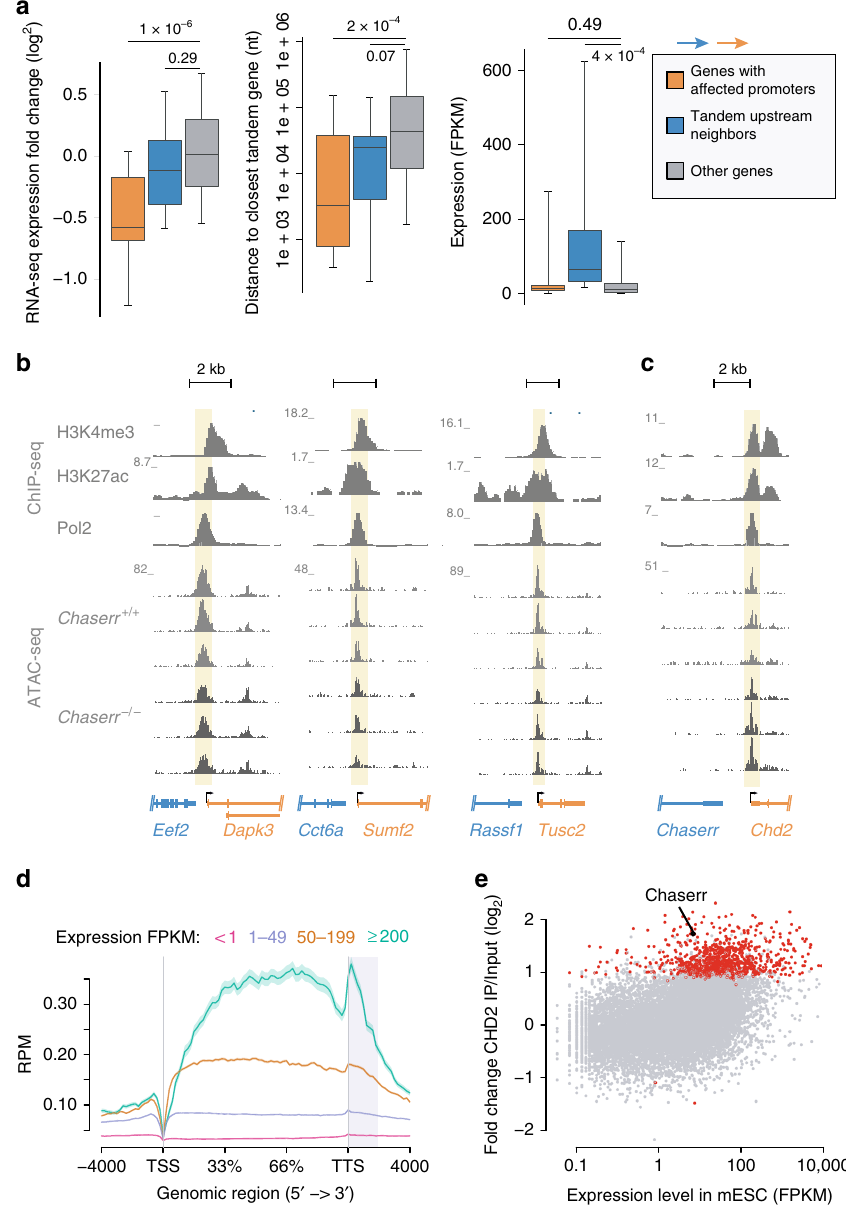
Fig. 5 Changes in chromatin accessibility following loss of Chaserr . a Changes in gene expression in Chaserr − / − mEFs, distance to the closest upstream gene transcribed from the same strand, and the expression levels, for genes assigned to promoter peaks with reduced accessibility in Chaserr − / − mEFs, their upstream neighbors on the same strand, and all other genes. Only genes with ATAC-seq peaks at their promoters were considered. P -values computed with two-sided Wilcoxon rank-sum test. Boxplots show the 5th, 25th, 50th, 75th, and 95th percentiles. b Examples of loci of genes with reduced accessibility in their core promoters in the Chaserr − / − background. Top: ChIP-seq coverage in mEFs from the ENCODE project. Bottom: read coverage in ATAC-seq data from mEFs isolated from three embryos from each background. c As in b , for the Chaserr / Chd2 locus. d Metagene of CHD2 occupancy 10 on genes in mESCs, divided into four groups based on their expression FPKM. e Enrichment of CHD2 occupancy in mESCs in the 2-kb region downstream of the TTS when compared with input, as a function of mESC gene expression levels. Genes with adjusted P < 0.05 are in red. Source data are provided as